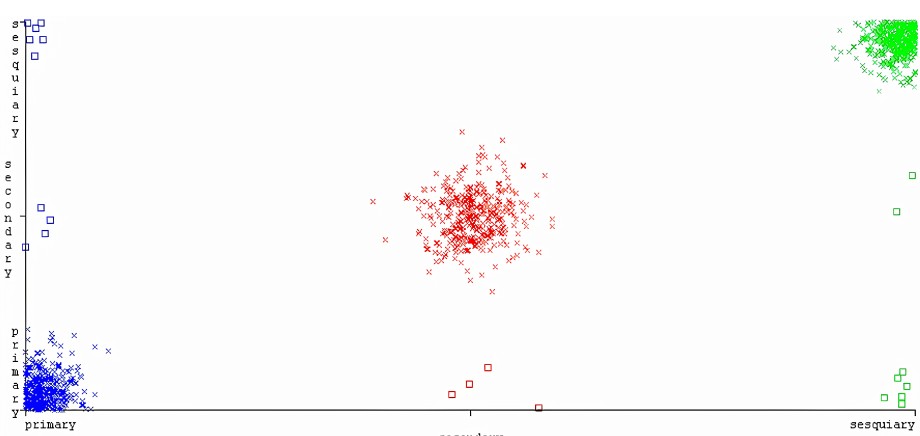
Figure 11. Visualization of classification results for Heavy rains tweets.